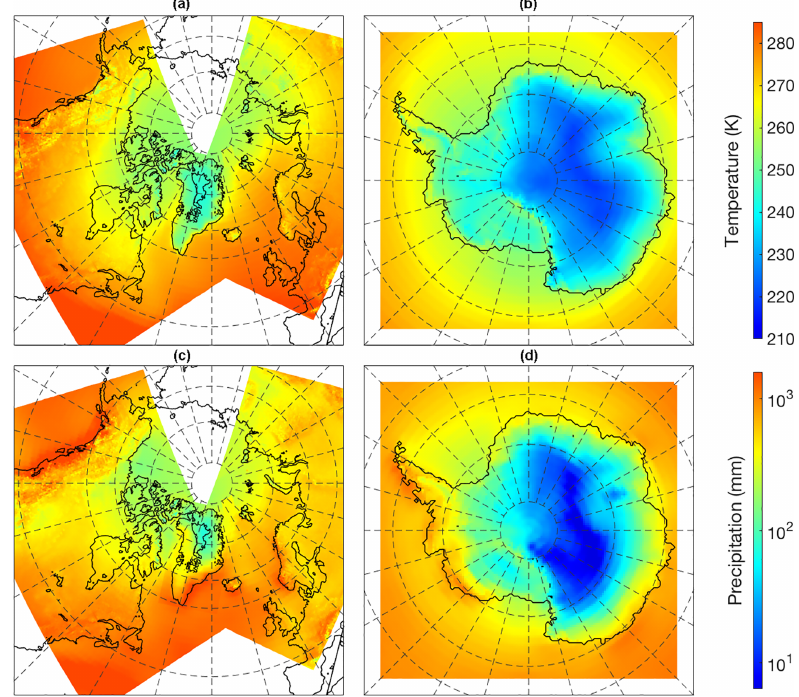
Figure A1. Annual mean 2m temperature for the Northern Hemisphere (a) and Antarctica (b) and the total annual precipitation (c, d) resulting from applying the constant lapse rate temperature change and the Roe precipitation model to the ERA-40 climate fields.